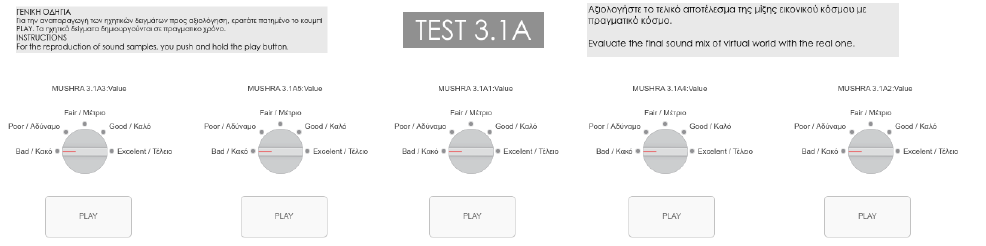
Figure A3. Discrimination test screen.